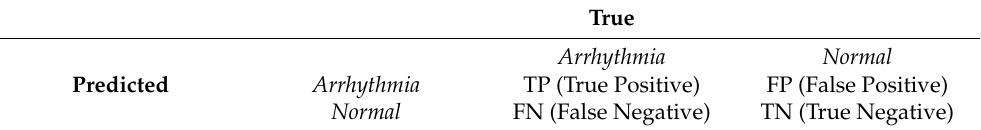
Table 3. Confusion